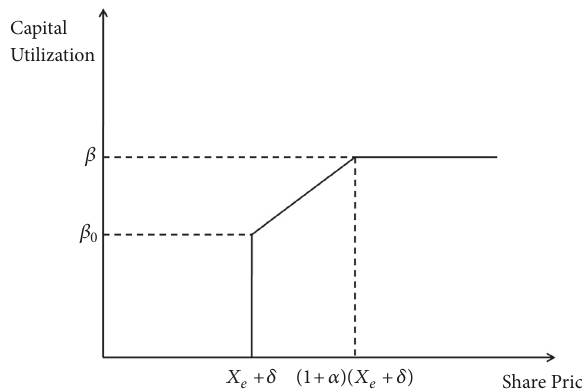
Figure 1: Capital utilization coefficient function along stock price under linear position